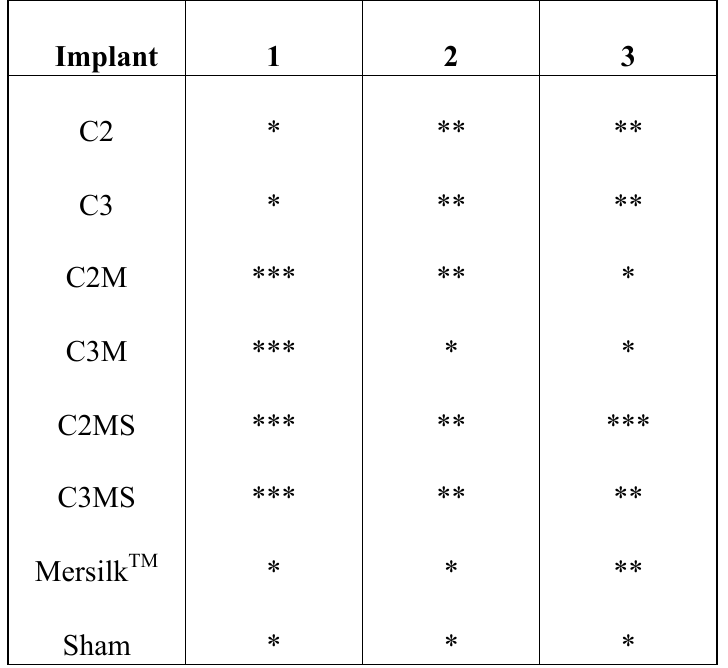
Table 2. Macroscopic appearances (graded * to ***) of all implants (see also Figure 2). Implants where the surrounding tissue shows no rubor is indicated by *, slight rubor at one pole of the implant is indicated by **, and rubor surrounding the whole implant is indicated by ***, see Figure 2 for examples. The implants are listed in the left column and the numbers (1-3) in the top row indicate the different rats. Abbreviations; C2, C3, C2M, C3M, C2MS, C3MS corresponds to different 4RepCT fibre treatments (see experimental section and Table